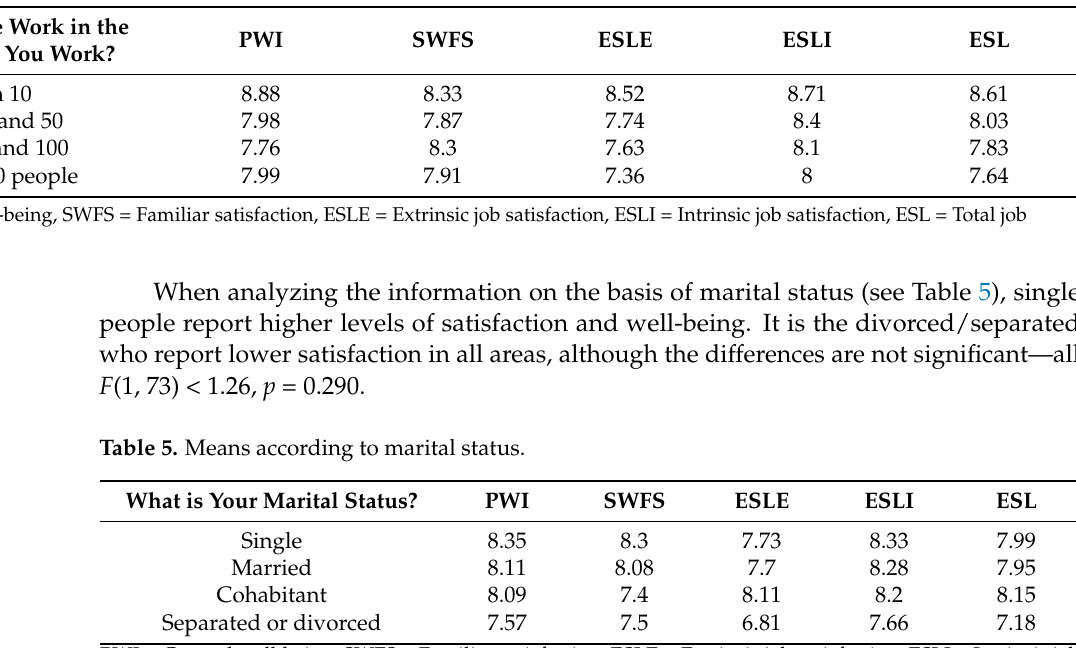
Table 4. Means according to company size.